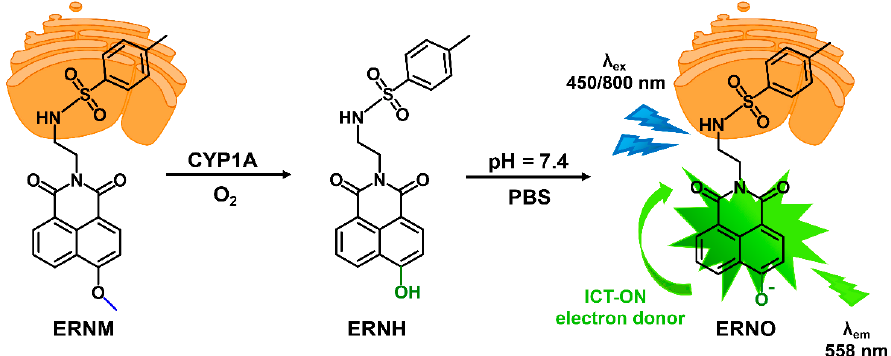
Scheme 1. Proposed mechanism of CYP1A triggering the fluorescence response of ERNM